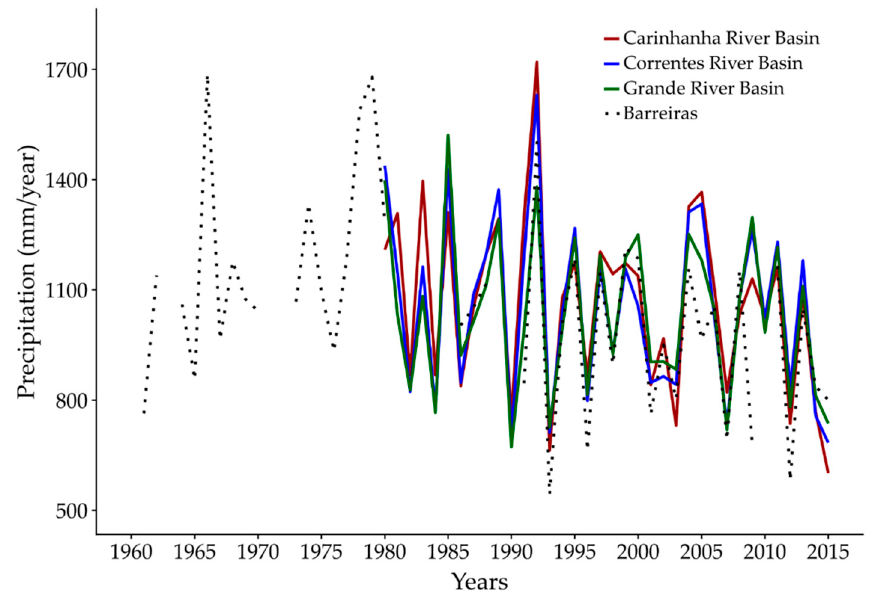
Figure 3. Annual mean precipitation for the three basins and historical precipitation for the Barreiras rain gauge.